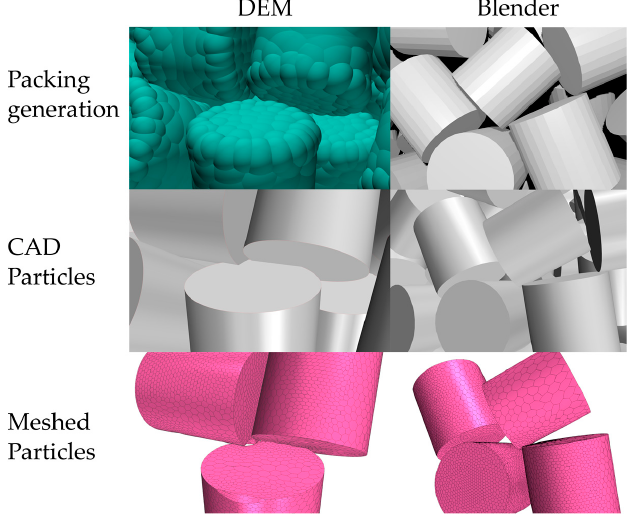
Figure 7. Bed generation with DEM ( left ) and rigid body ( right ), CAD particle transformation, and resulting mesh.